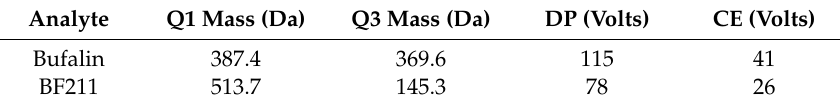
Figure 2. Mass spectrograms of product ions of bufalin ( B ) and BF211 ( A ) in positive mode. Table 3. Optimized mass spectrometry conditions for bufalin and BF211.